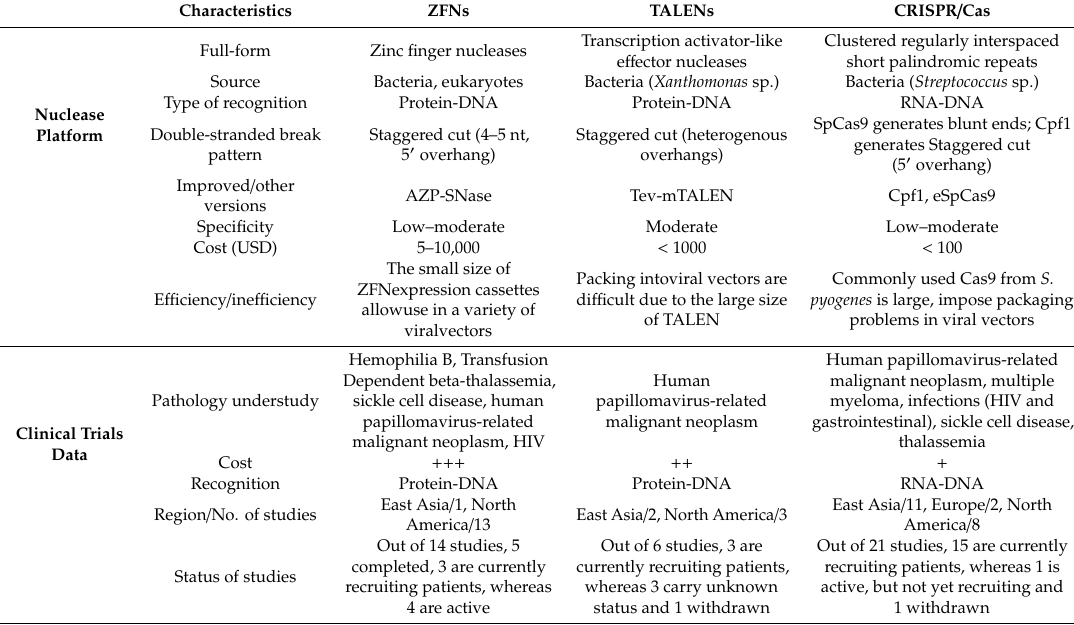
Table 1. Comparison between ZFNs, TALENs and CRISPR / Cas on the nuclease platform and clinical trial data